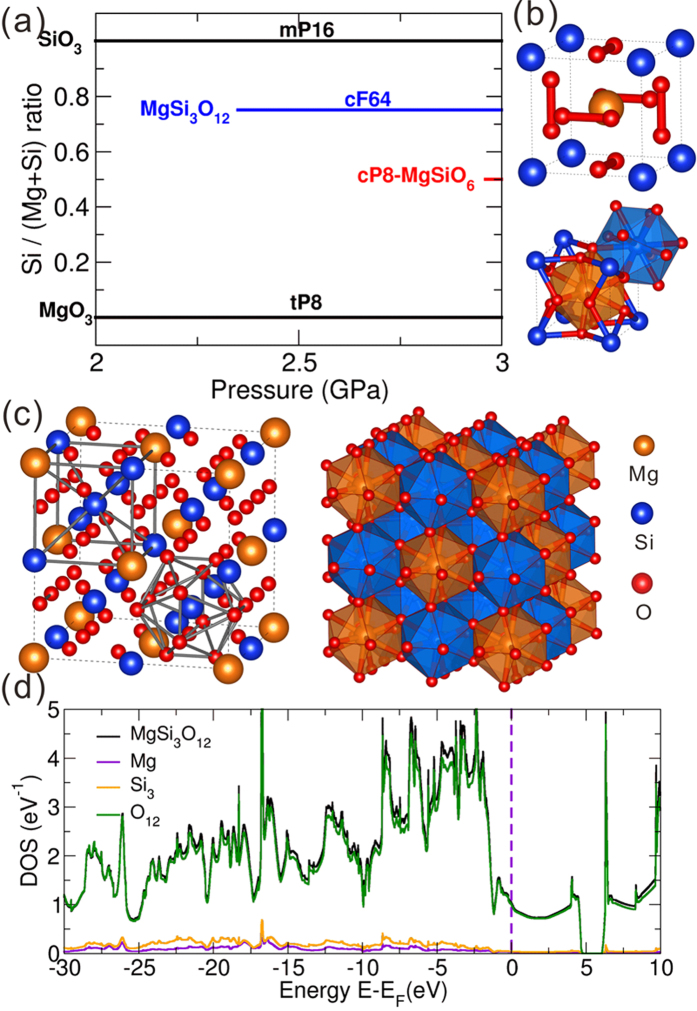
(a) Pressure-composition phase diagram of the pseudo-binary MgO3-SiO3 system and crystal structures of (b) MgSiO6 and (c) MgSi3O12, and (d) density of states (DOS) of cF64-MgSi3O12. The density of states of cP8-MgSiO6 is shown in Fig. S8 in Supplementary Materials.